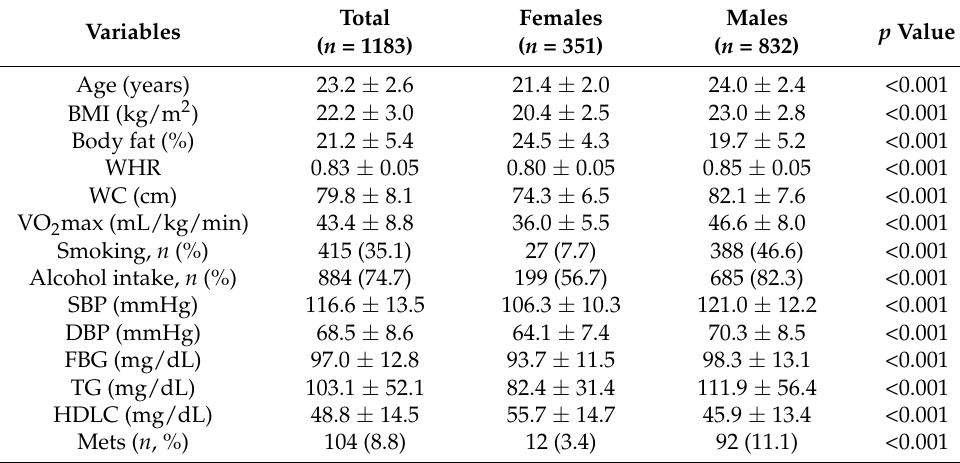
Table 1. Description of study participants.